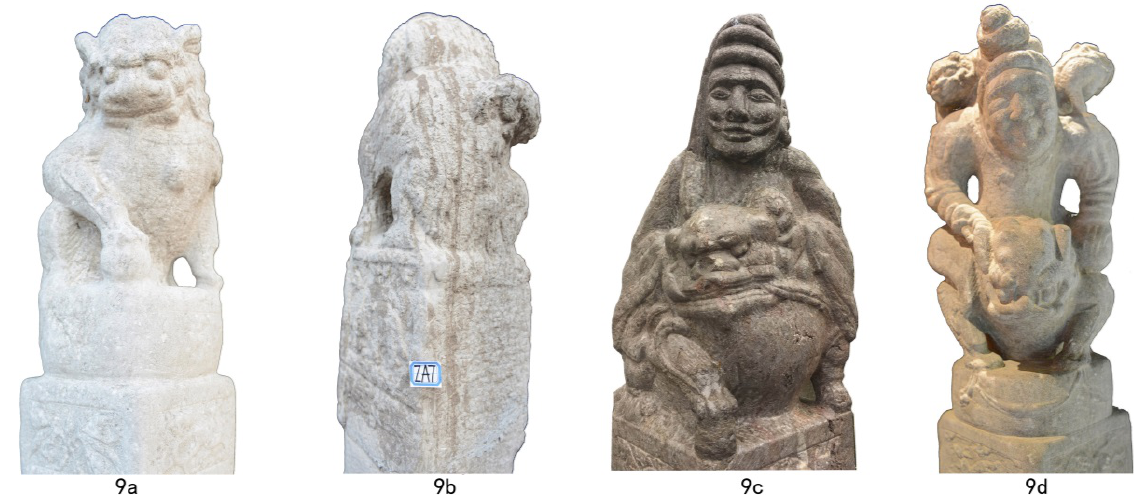
Figure 9. Lions and Huren on lions: a) Lion, Chengcheng county museum; b) Mother and baby lions (backside), Chengcheng county museum c) Huren on a lion, Chengcheng county museum; d) Huren on a lion with baby lions on his shoulder, Chengcheng county